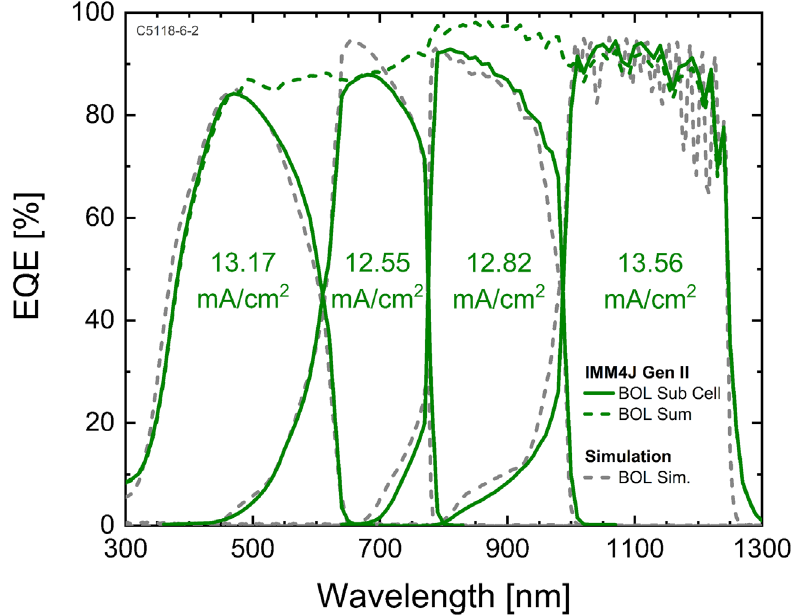
Fig. 5. Plot of the measured EQEs of each subcell (solid lines) and of the sum (dotted line) of a Gen II IMM4J solar cell. The dashed line represents the realistic near-term potential simulation of the subcell EQEs. Subcell current densities were calculated from the subcell EQEs for the case of the AM0 spectrum.